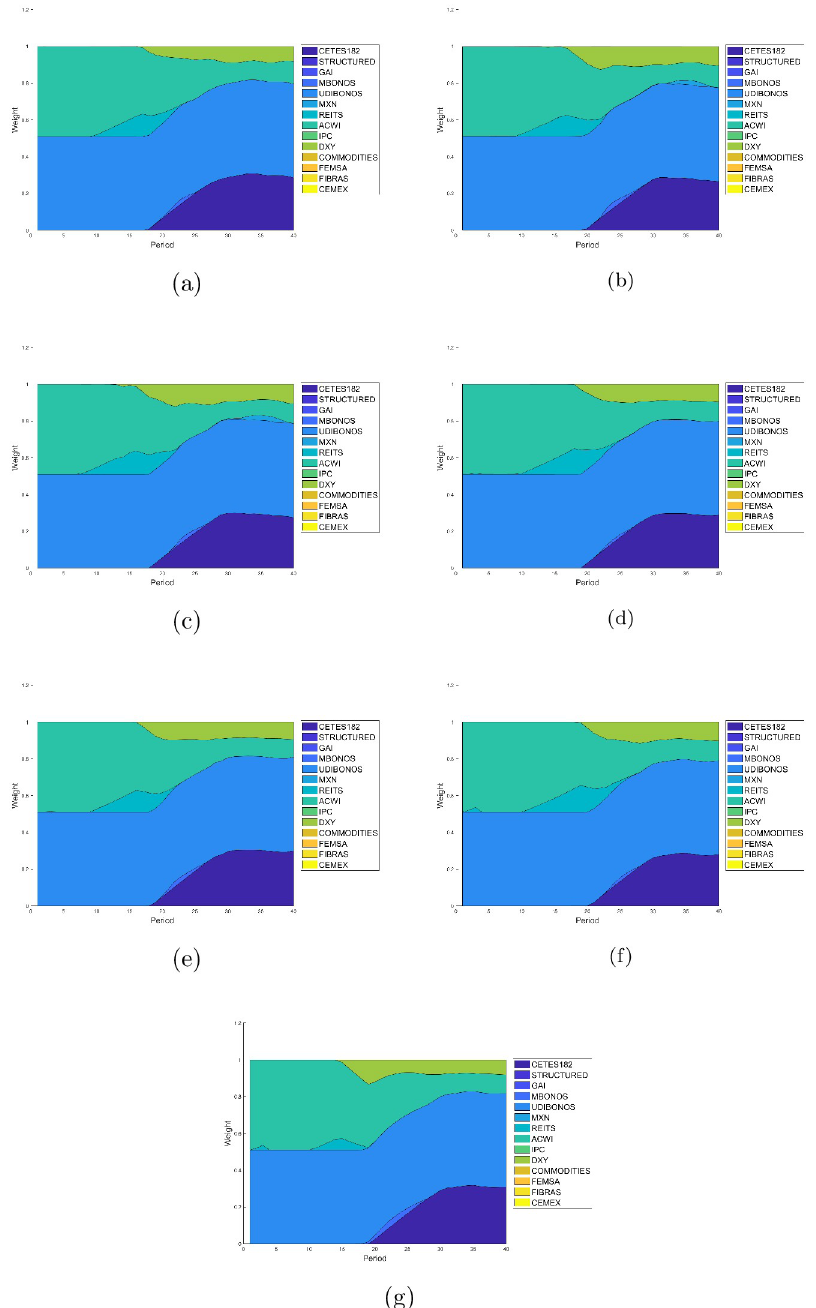
Fig 12. Allocation weights from the solution with the highest Sharpe ratio. (a) Case E1 with E { W ( T )} = 21.2941 and var { W ( T )} = 0.5862. (b) Case E2 with E { W ( T )}= 20.9075 and var { W ( T )} = 0.5725. (c) Case E3 with E { W ( T )}= 20.0420 and var { W ( T )} = 0.5541. (d) Case E4 with E { W ( T )}= 21.3277 and var { W ( T )} = 0.5619. (e) Case E5 with E { W ( T )}= 20.8319 and var { W ( T )} = 0.4588. (f) Case E6 with E { W ( T )}= 22.3193 and var { W ( T )} = 0.6408. (g) Case E7 with E { W ( T )} = 21.3277 and var { W ( T )} = 0.5285.